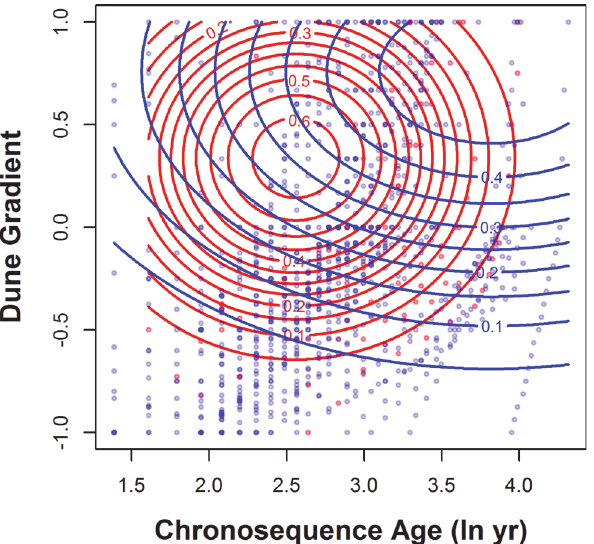
Fig 2. Contour plot of Ammophila cover shows distinct species distributions across chronosequence ages and dune gradient. Contours show areas of increasing cover across both gradients. Contours were created using predicted values of generalized linear models (see main text for details). Chronosequence ages were calculated for each quadrat using aerial photos and shoreline change rates (see main text for details). Dune gradient was calculated for each quadrat based on its standardized location along dune cross sections with the toe, crest, and heel at-1, 0, and 1, respectively. Each point on figure refers to the chronosequence age and dune gradient for an individual quadrat. Sites dominated by A . arenaria are shown in red, and those from A . breviligulata sites shown in blue.